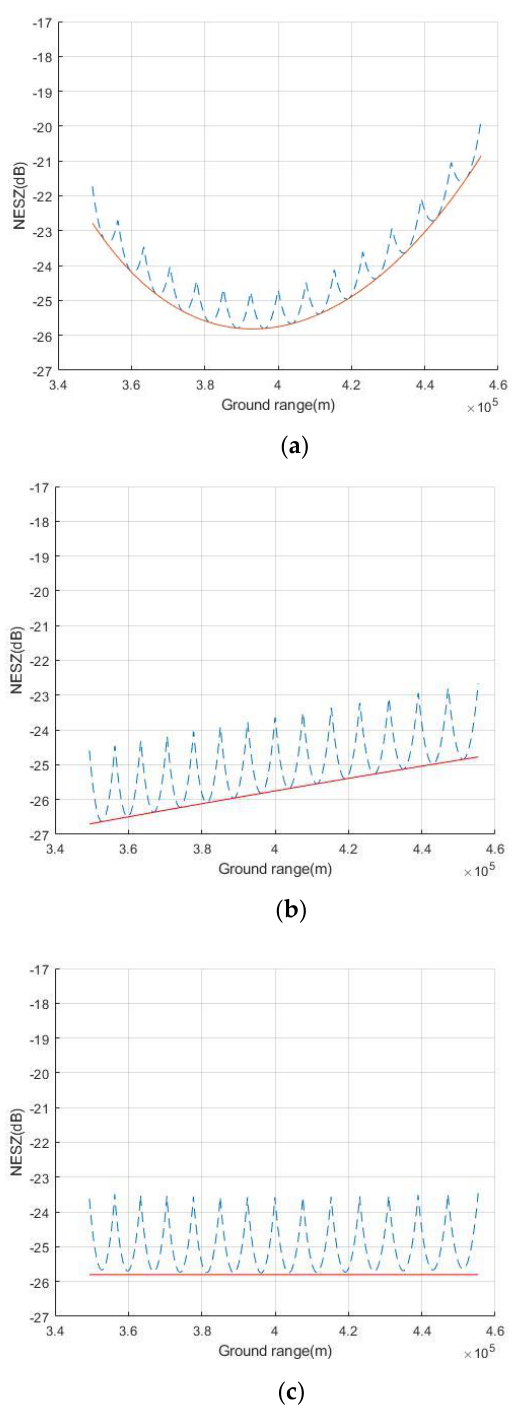
Figure 13. Noise equivalent sigma zero (NESZ) of the system. ( a ) NESZ of the system in [6]. ( b ) NESZ of the system proposed in this paper when the energy is evenly distributed to each subswath. ( c ) NESZ of the system proposed in this paper when the energy is distributed to each subswath as needed.